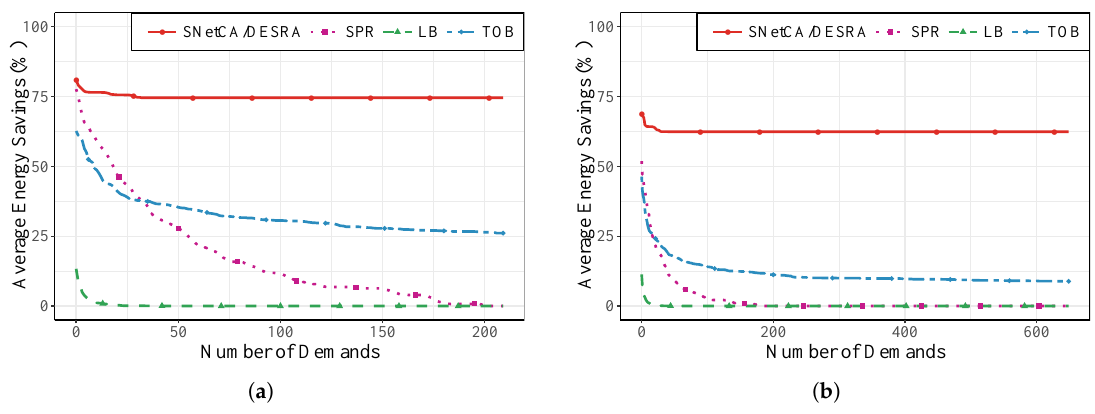
Figure 14. Average energy savings with | C | = 1 in the: ( a ) New York topology; and ( b ) Norway